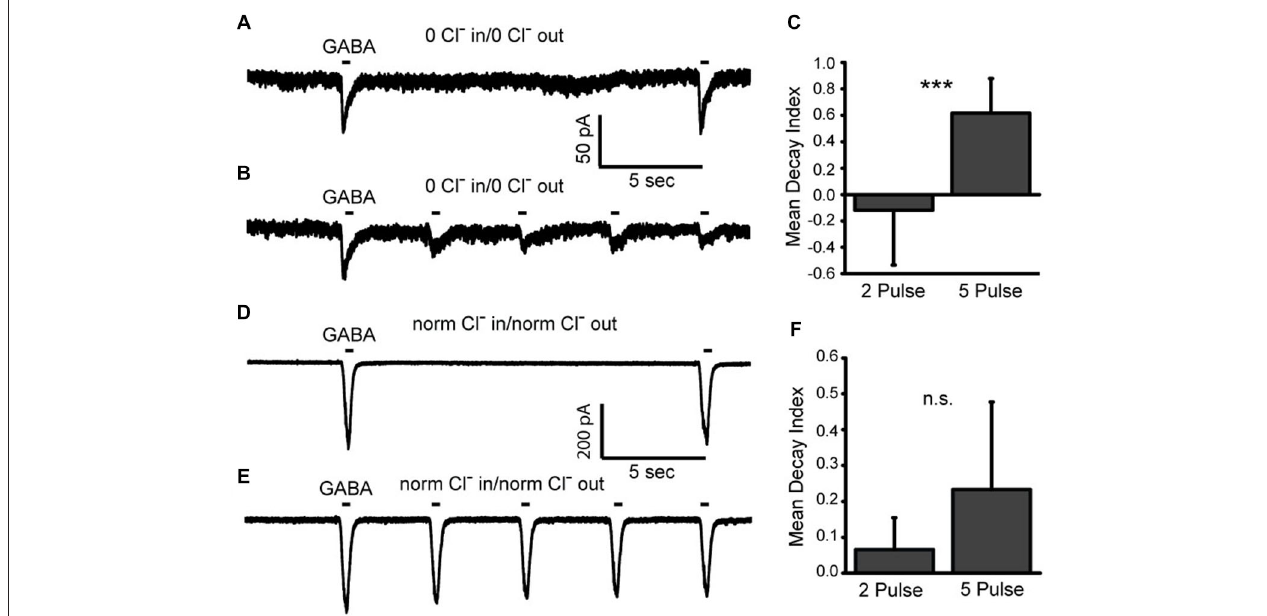
decay in the amplitude of GABA-gated currents is accelerated when the receptors are activated more frequently. (D,E) , Data from two different amacrine cells recorded as in (A) but in the presence of normal intra and extracellular Cl − concentrations. (F) , Decay indices are plotted for cells recorded under the conditions in (C) and no significant difference in current amplitude is observed. *** denotes p <